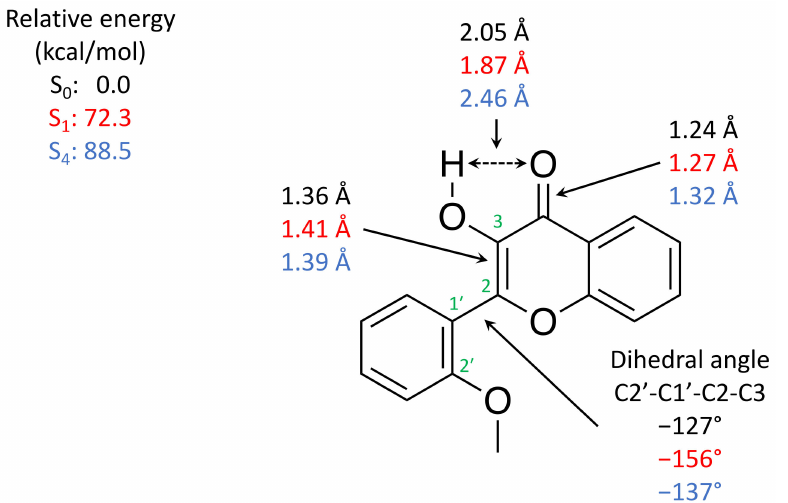
Figure 3. Relative energies (in kcal/mol) and representative bond lengths in angstroms and dihedral angle in degrees for the optimized ground state (S 0 in black), first excited state (S 1 state in red) and fourth excited state (S 4 state in blue), respectively, from Franck–Condon geometry of 1b at the TD-B3LYP/6-311G(d) level of theory with SMD models in